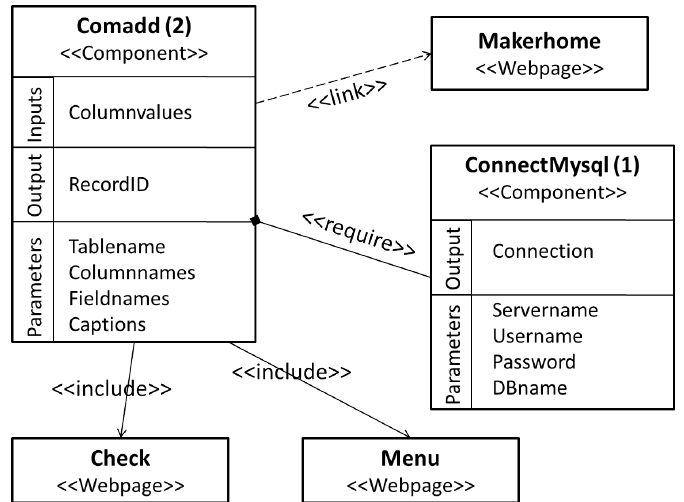
Figure 8. CPIM for add